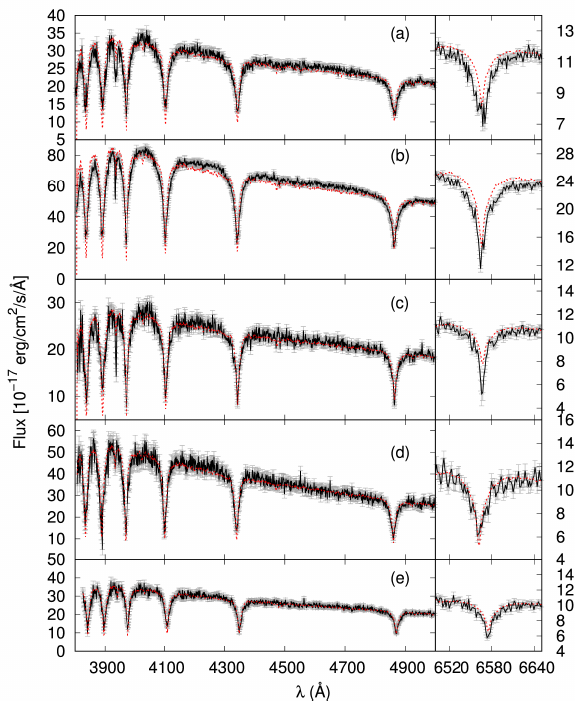
Figure 10. Spectra for the five objects showing ∆V > 200 km/s (solid black line). The SDSS template is shown as a dashed red line for comparison. For the object with two spectra, the highest S / R spectrum is shown.